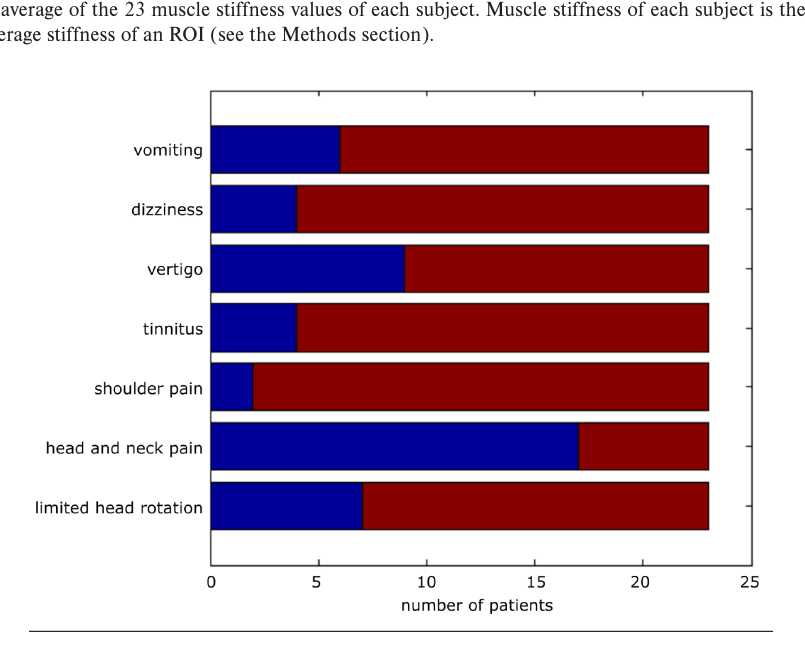
Fig. 5. The distribution of additional adverse effects in the population suffering from cervicogenic